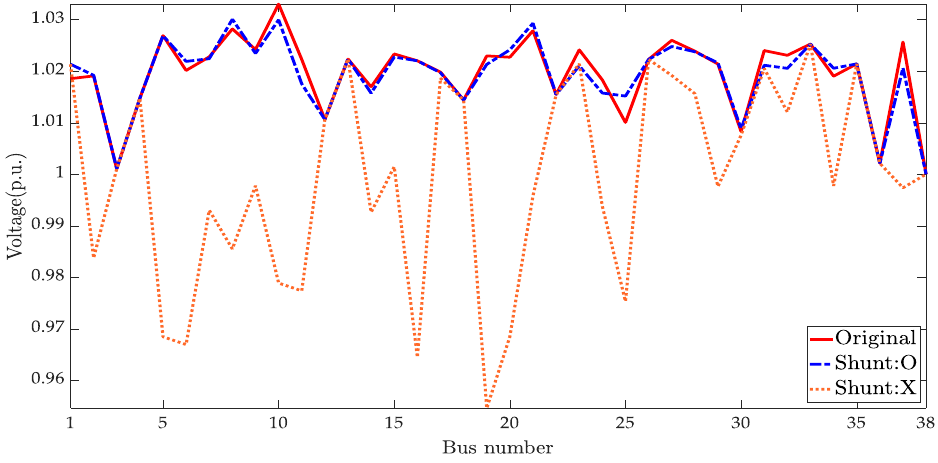
Figure 9. Comparison of bus voltage magnitudes.